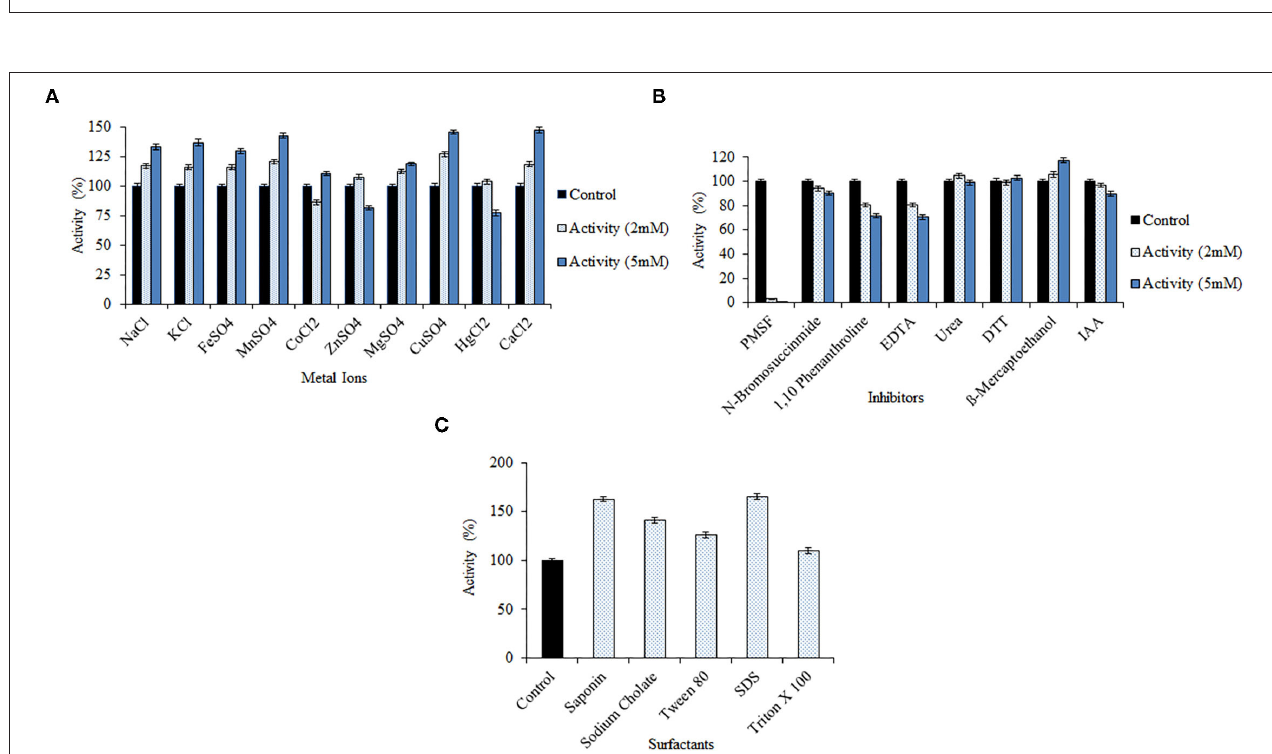
FIGURE 4 | Effect of various metal ions/inhibitors/surfactants on the keratinolytic activity of the enzyme from Bacillus pacificus RSA27. (A,B) Effect of metal ions and inhibitors (2 and 5mM). (C) Effect of surfactants (1% solution with water).